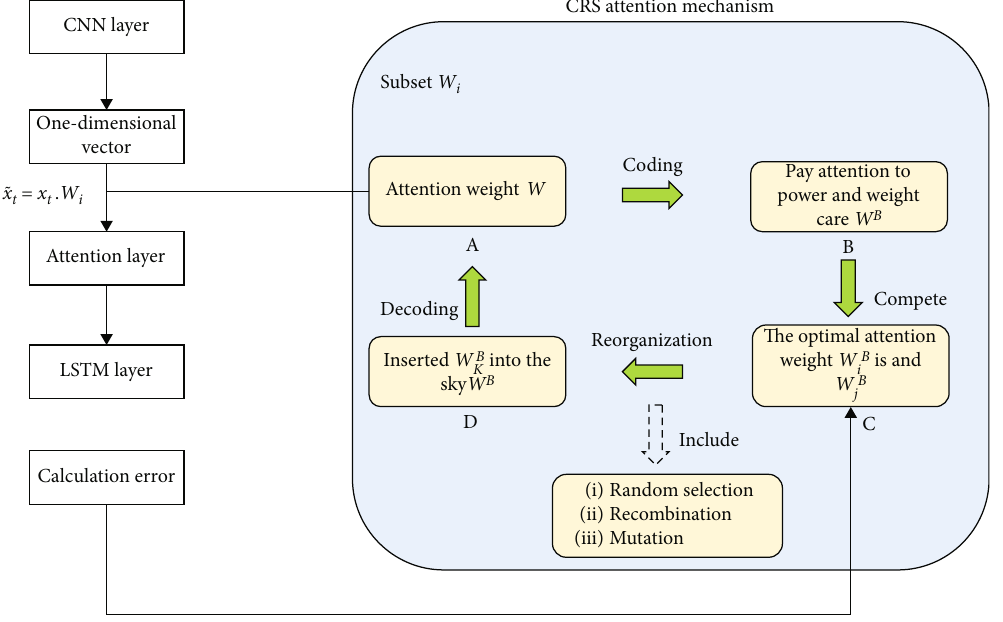
Figure 11: CRS integrated IAM structure.